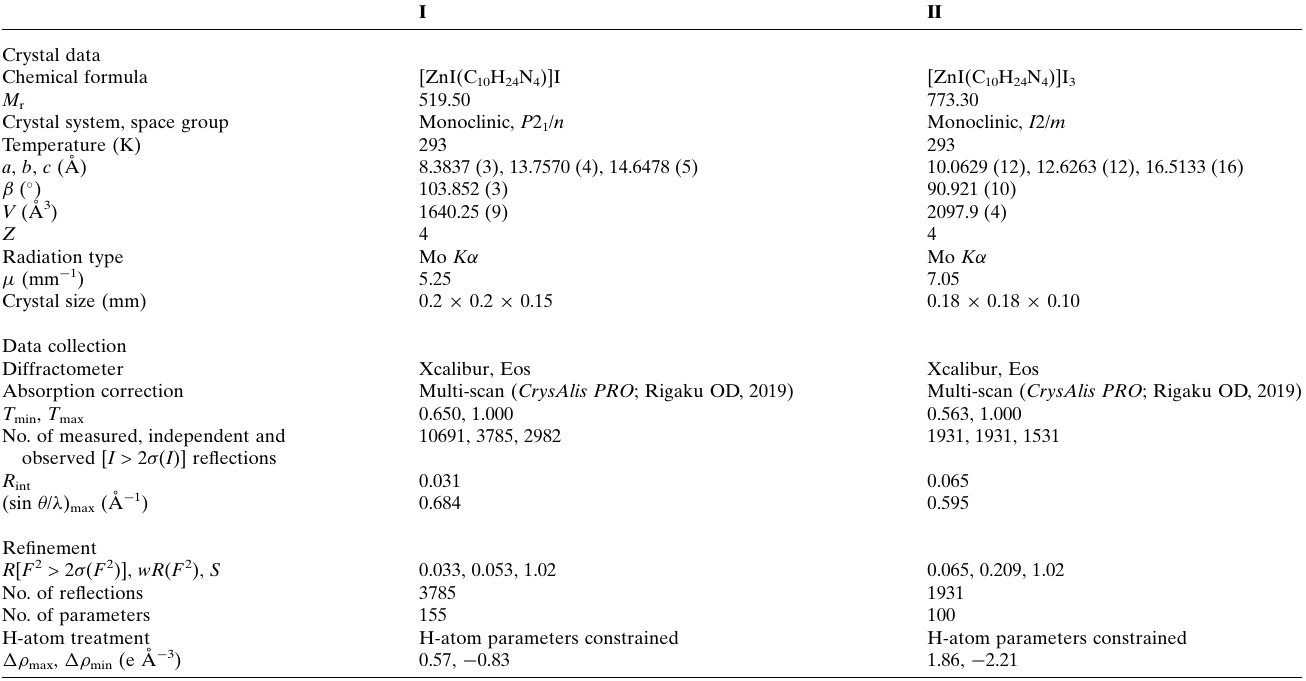
Table 3 Experimental